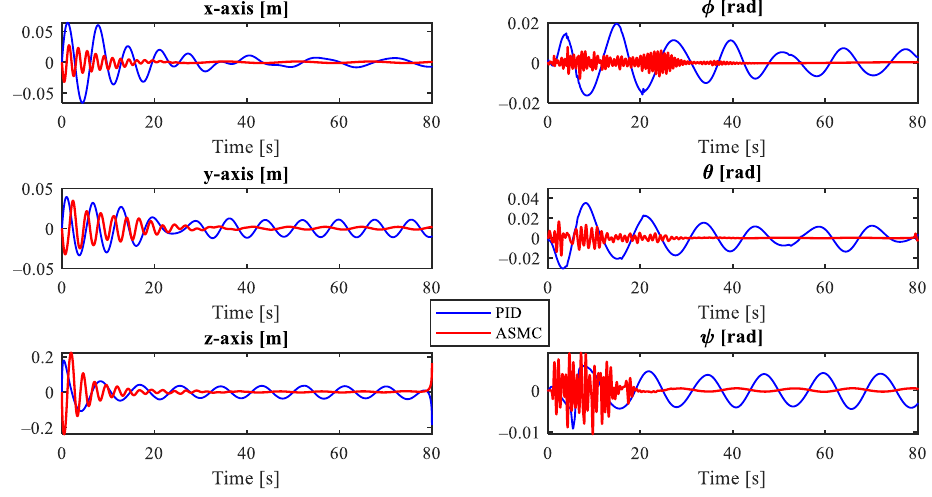
Figure 9. Tracking errors in the approaching stage.